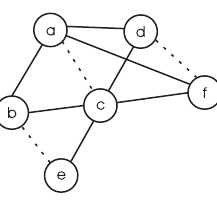
Figure 1. Example of social rule. The figure represents a hypothetical snapshot of graph G at time t during network evolution. Straight links indicate already existing edges whereas the dashed lines indicate the ones that will be added in the following steps. Edge ( a , c ) closes three triads ( a , d )( d , c ) , ( a , b )( b , c ) , and ( a , f )( f , c ) , whereas ( d , f ) and ( b , e ) only close two and one triangle respectively. Therefore, the probability of been selected at time t + 1 is 0.5, 0.33 and 0.16